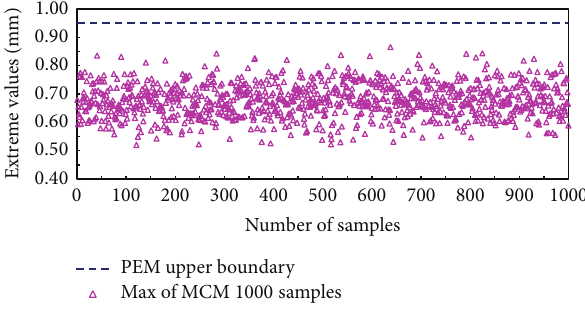
Figure 13: Comparison of wheel load decrement ratio of motor car.